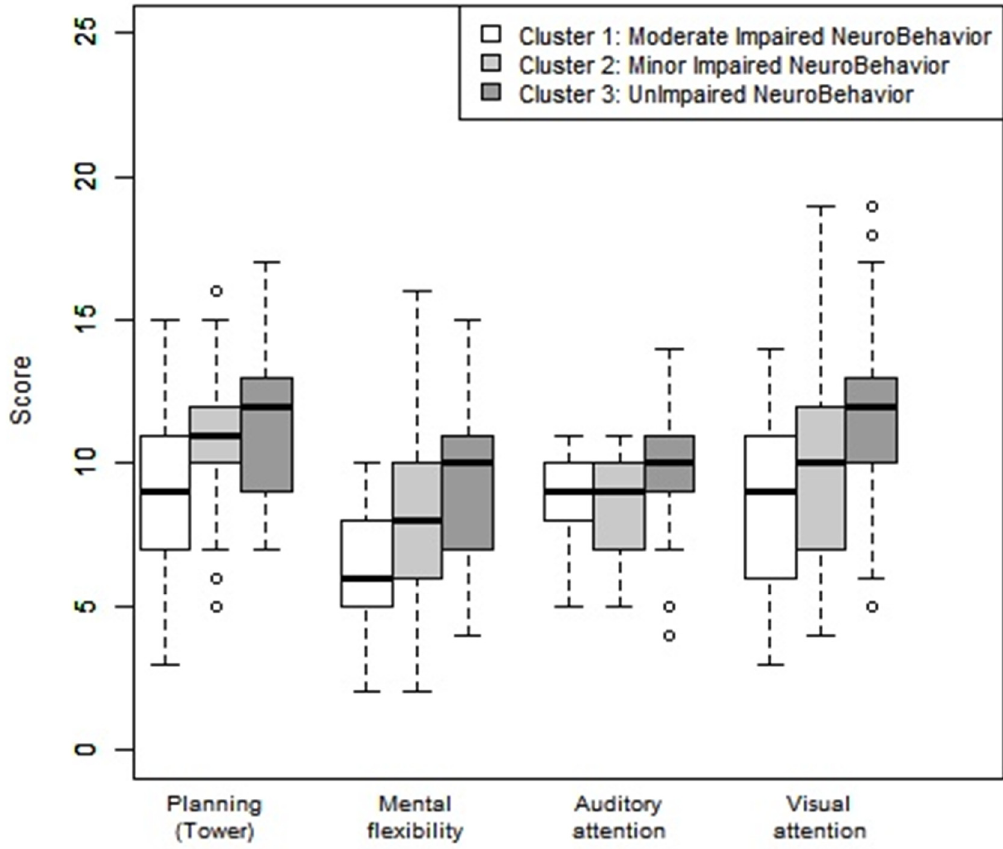
Figure 3. Neuropsychological assessment: planning, mental flexibility, auditory, and visual attention according to the clusters. Note: Average: 10, deviation: 3. A <8 score reflected a disorder in the category concerned: < − 1 SD).